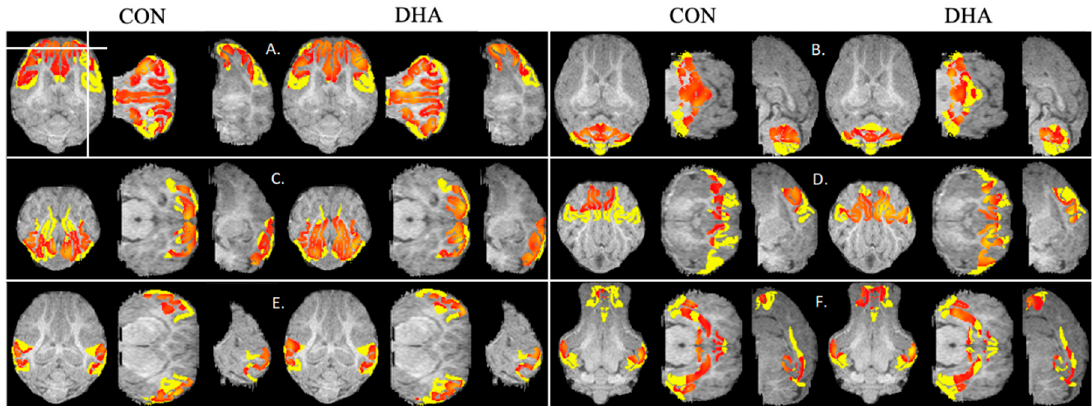
Figure 7. Color-coded regions illustrating activation within six RSNs, including ECN ( A ), CERE ( B ), VIS ( C ), SMN ( D ), AUD ( E ), and DMN ( F ), in piglets born to sows fed a CON ( n = 7) or DHA ( n = 7) diet. Each session contains activation maps of CON (left) and DHA (right) piglets in axial, coronal, and sagittal planes. Horizontal and vertical bars on the axial image at the upper-left corner indicate locations of the coronal and sagittal images. Yellow patters are RSN atlases and orange patters are activations. Abbreviations: CON: control; DHA: docosahexaenoic acid. RSN: resting state network; ECN: executive control network; CERE: cerebellar network; VIS: visual network; SMN: sensorimotor network; AUD: auditory network; DMN: default mode network.